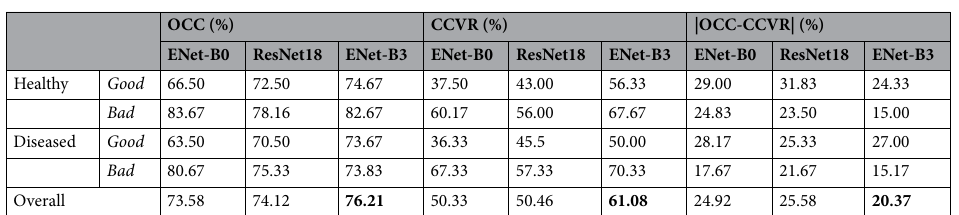
Table 2. Mean scores of subjective grading performed on CTMs. Significant values are in bold.